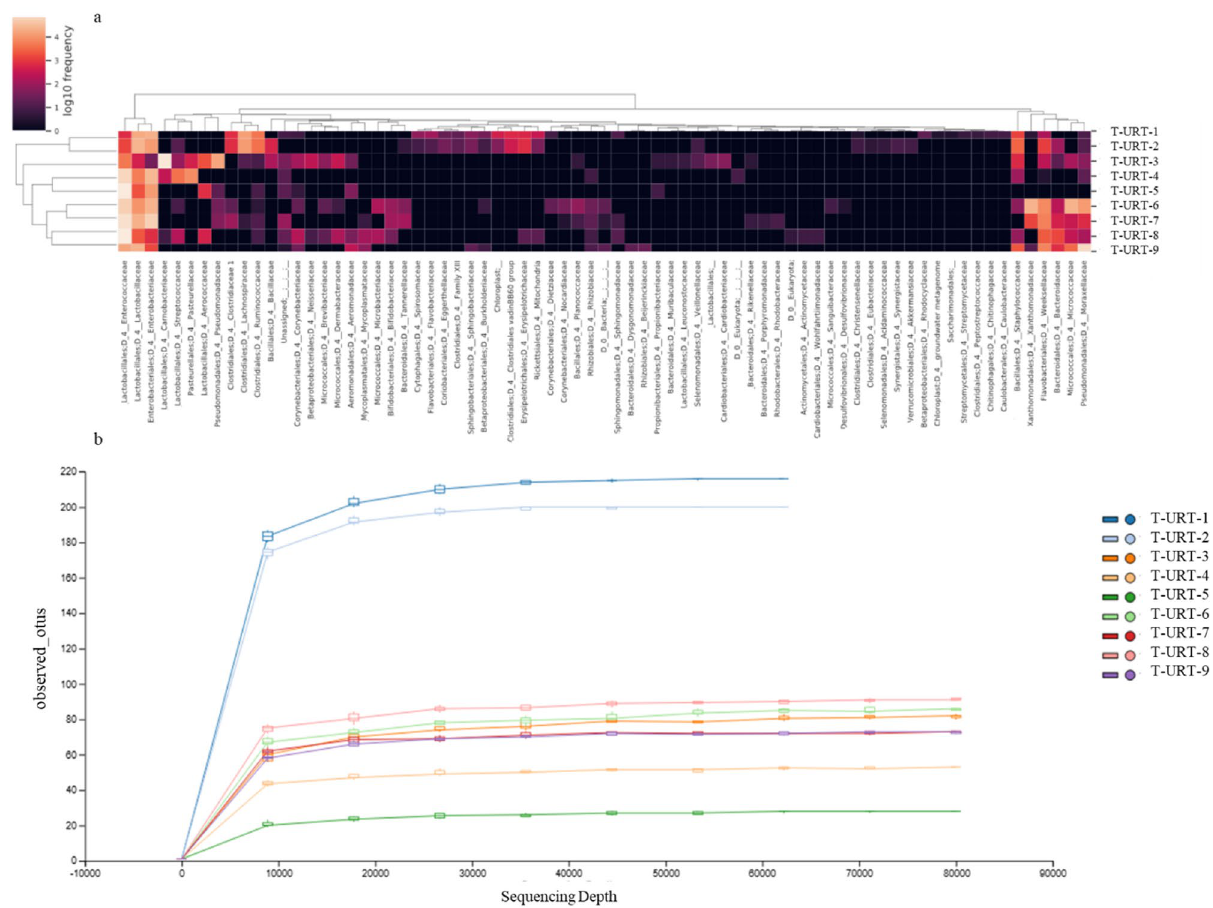
Figure 3. Heatmap of bacterial OTUs in turkeys URT. ( a ) Heatmap of bacterial OTUs in the upper respiratory tract of turkeys. Heatmap depicting abundance of all 73 OTUs by overall abundance across samples. Normalized heatmap on taxonomic level 5 was constructed with clustering on both samples and feature axes. ( b ) Observed OTUs comparing URT flocks.